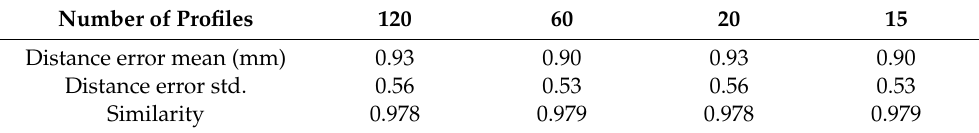
Table 3. Error evaluation for surface estimates of Model B.